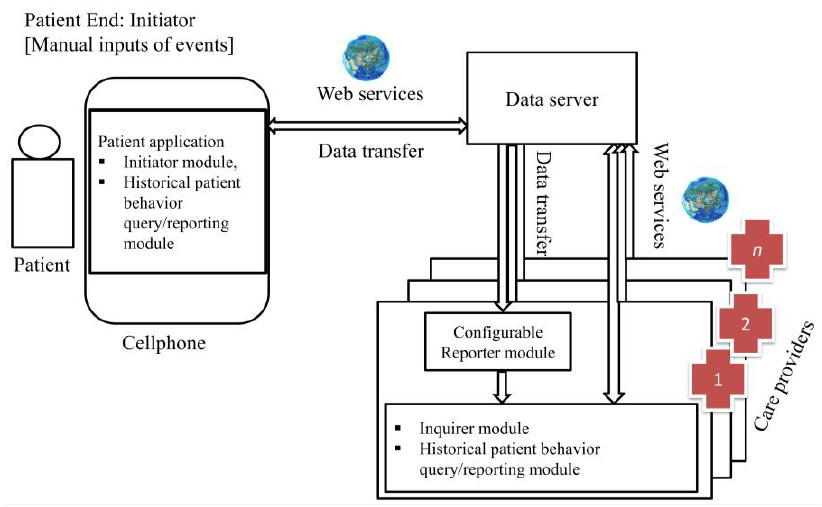
Figure 28. Conceptual design of the eCC system: patients connected to care providers [7].